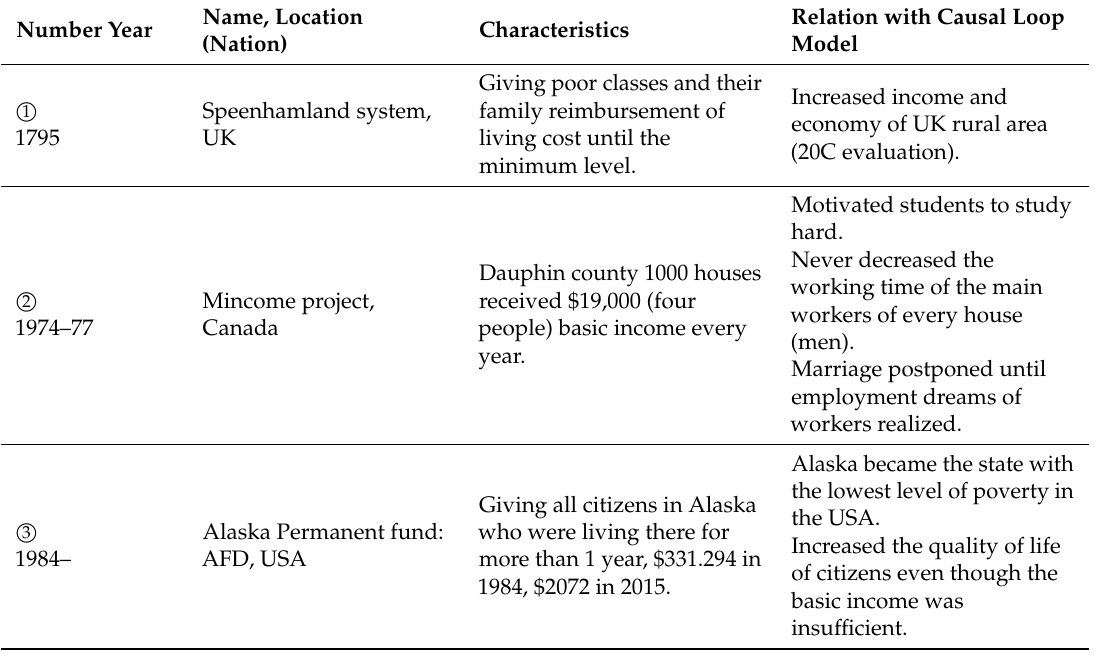
Table 1. Summary of diverse basic income policies in global economic